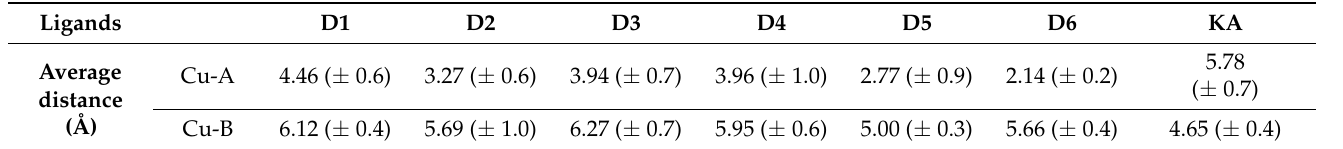
Table 2. The average distance (Å) obtained from MD simulations between the carbonyl (O1) 4H-pyrone group of the KA and their derivatives with copper ions (Cu-A and -B). Ligands Average distance